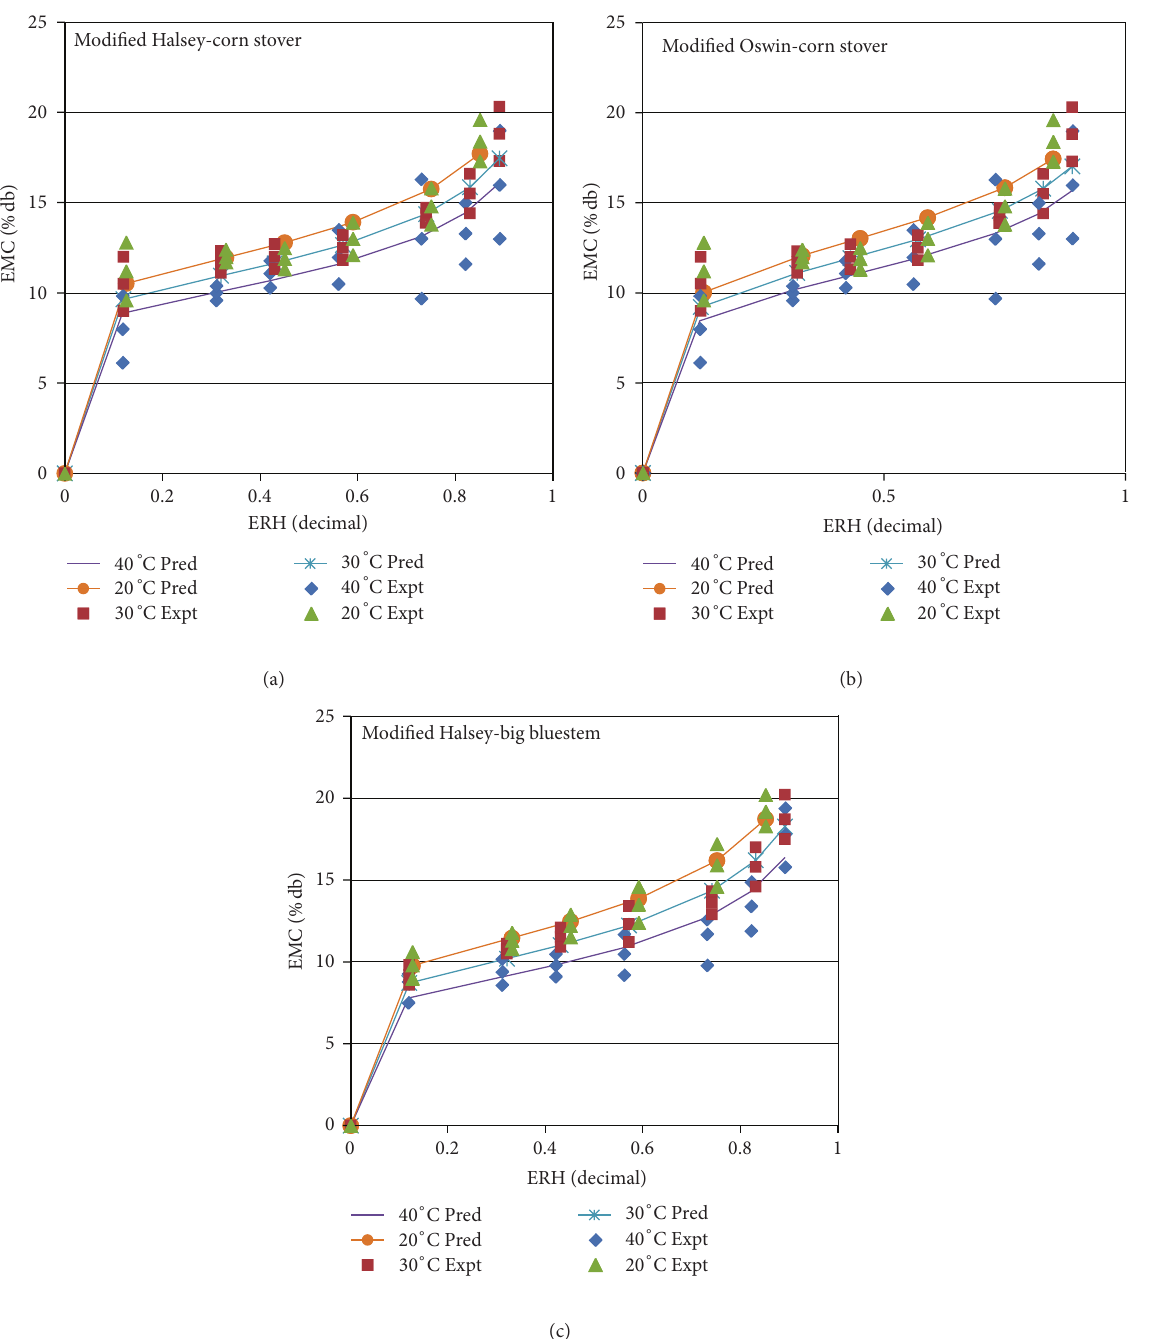
Figure 4: Comparison between observed and modified Halsey and modified Oswin equations predicted sorption isotherms of corn stover and big bluestem at indicated temperatures (Expt: experimental: Pred;